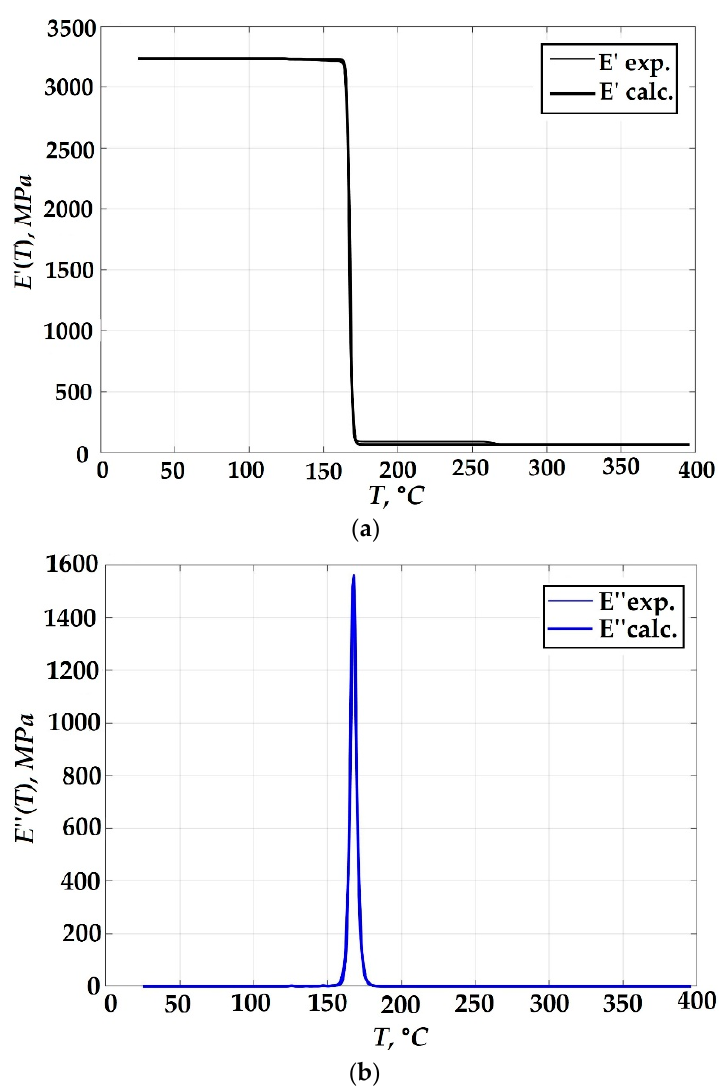
Figure 5. The result of the approximation of the temperature dependence of the complex PEEK module when cooled at a rate of T = 1 K · s − 1 : ( a ) is the real part; ( b ) is the imaginary part. “Experiment” is a reproduction of experiment results [7] by calculating (32), “Calculation” is the calculation by (21–22). Table 5. Values of instantaneous properties of viscoelastic material.